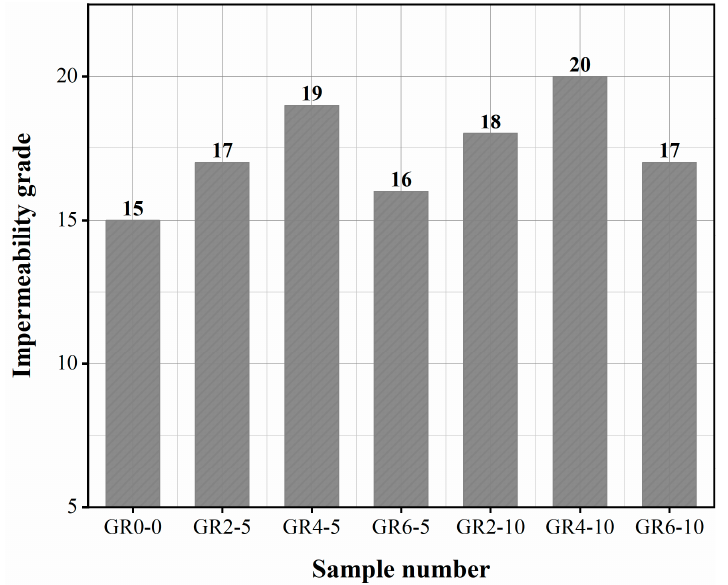
Figure 12. Impermeability grade of